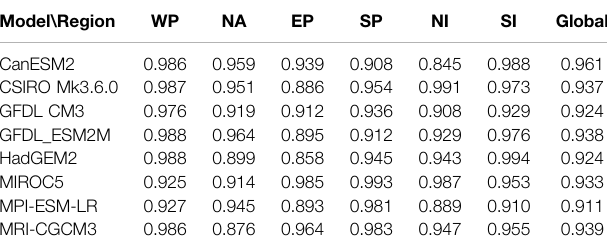
TABLE 2 | Index of geographical properties of TC track for eight CMIP5 models in different areas and globe